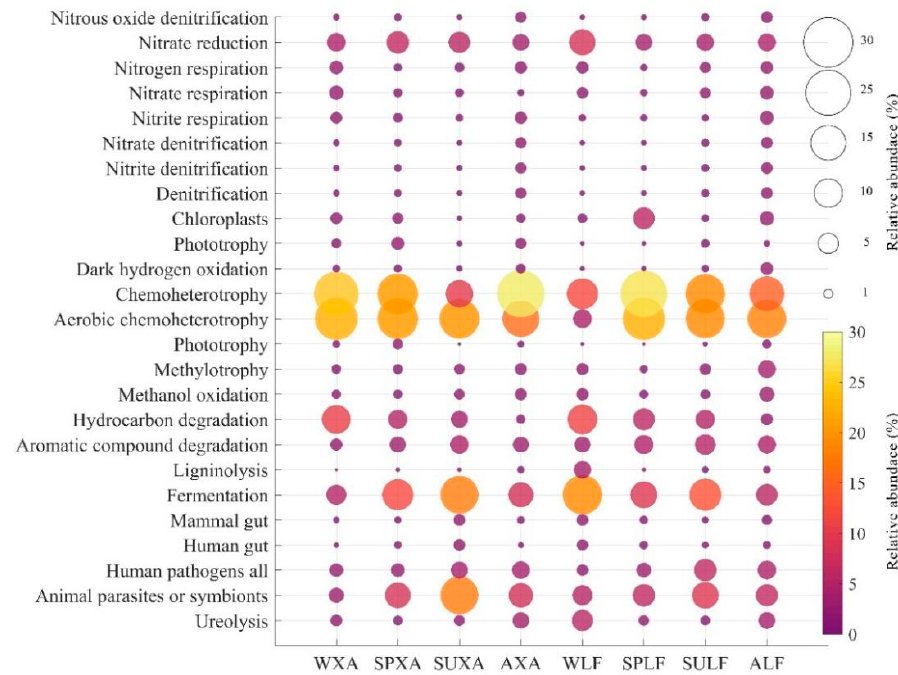
Figure 5. Relative abundance of top 25 functional groups in the four seasonal samples were based on the FAPROTAX database. The size and the color of the balloons represent the relative abundance (%) of bacterial community function.